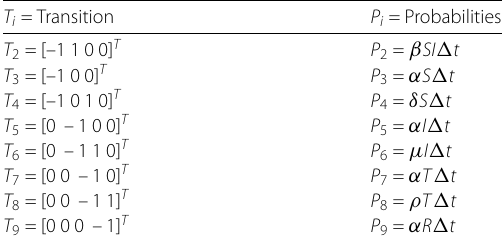
Table 1 Transition